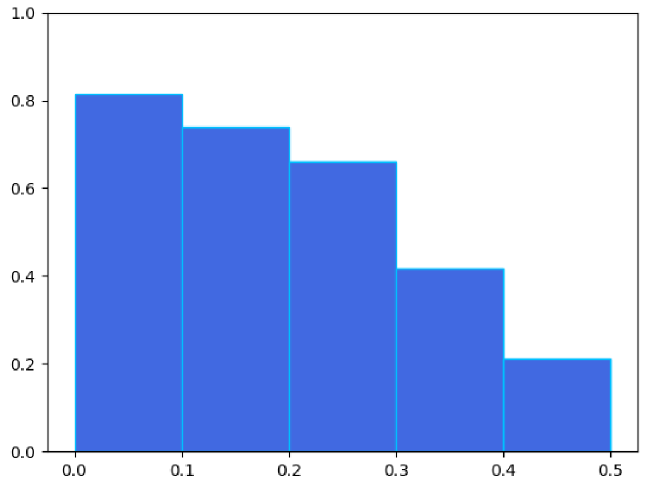
Fig 5. Origin rate of segments in discharge summaries against the inpatient records. Proportion of unsourced segments appearing in manually annotated data. The y-axis is the value averaged every 0.1 steps for segments with origin rates less than 0.5, as shown in Fig